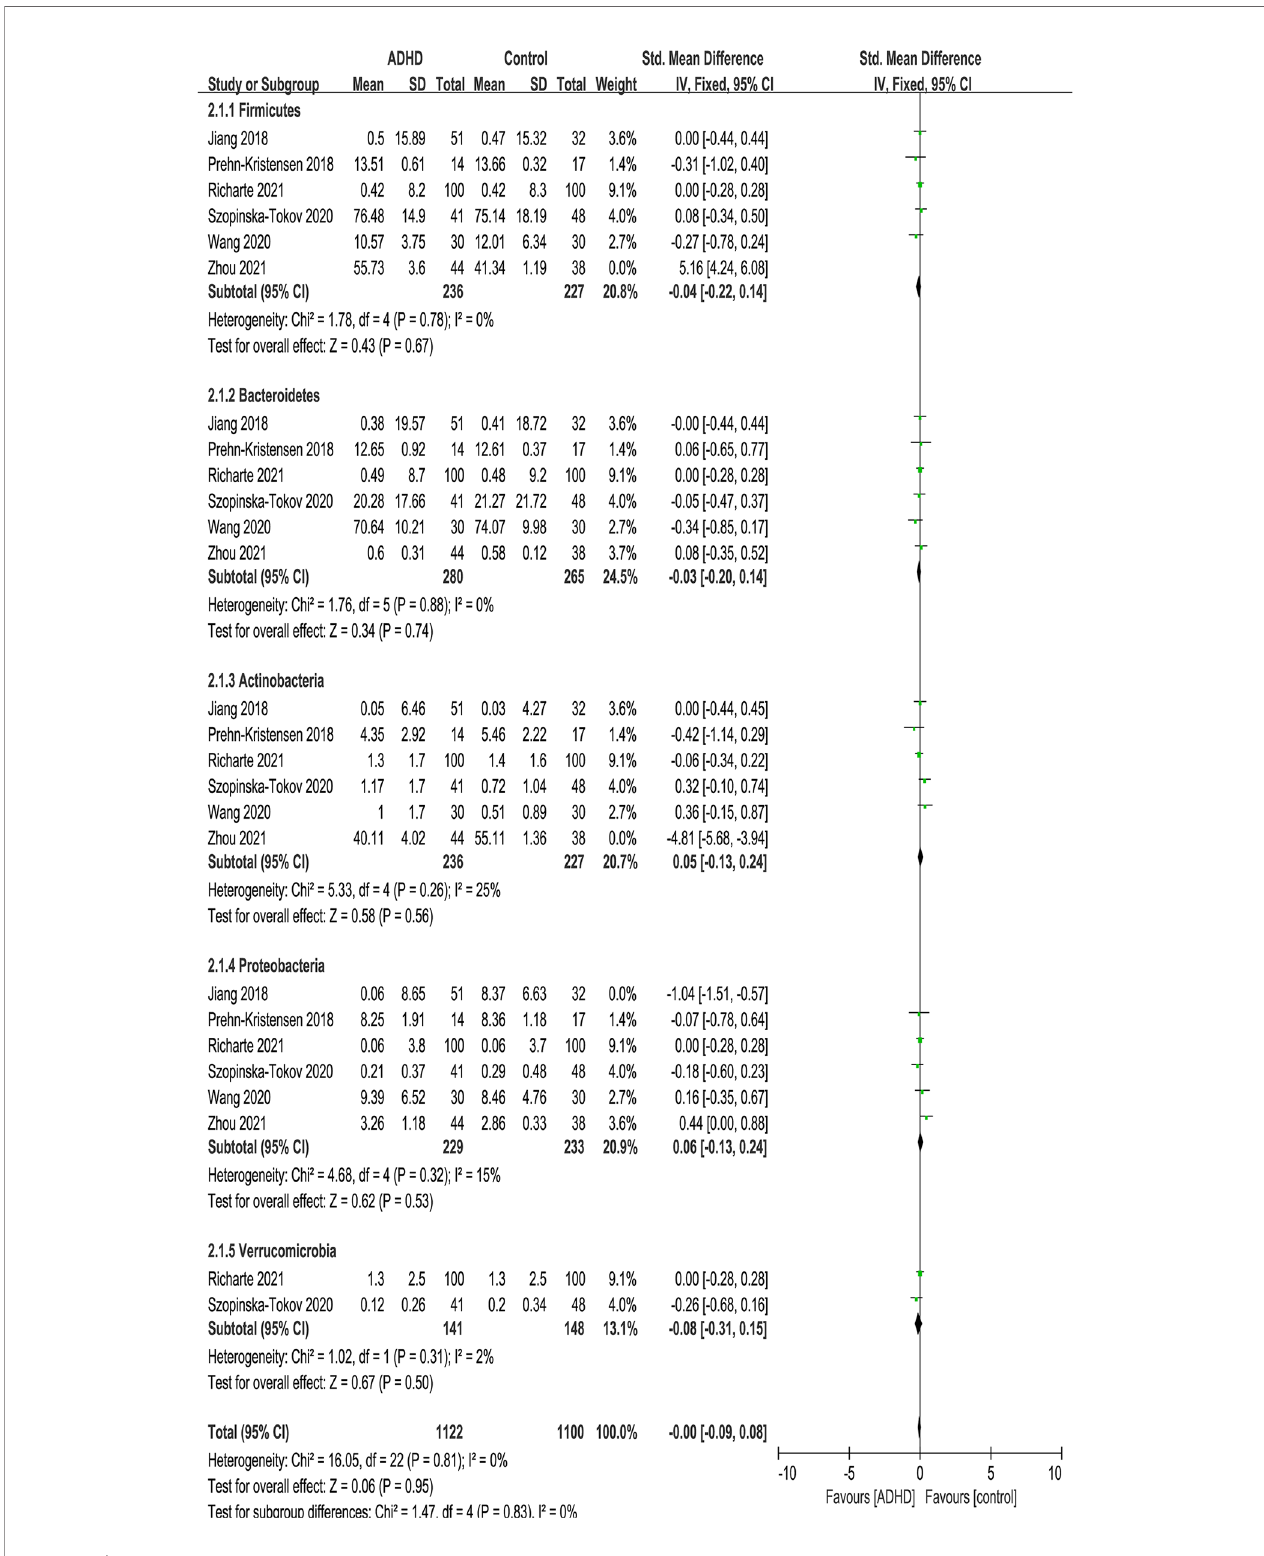
Frontiers in Endocrinology |